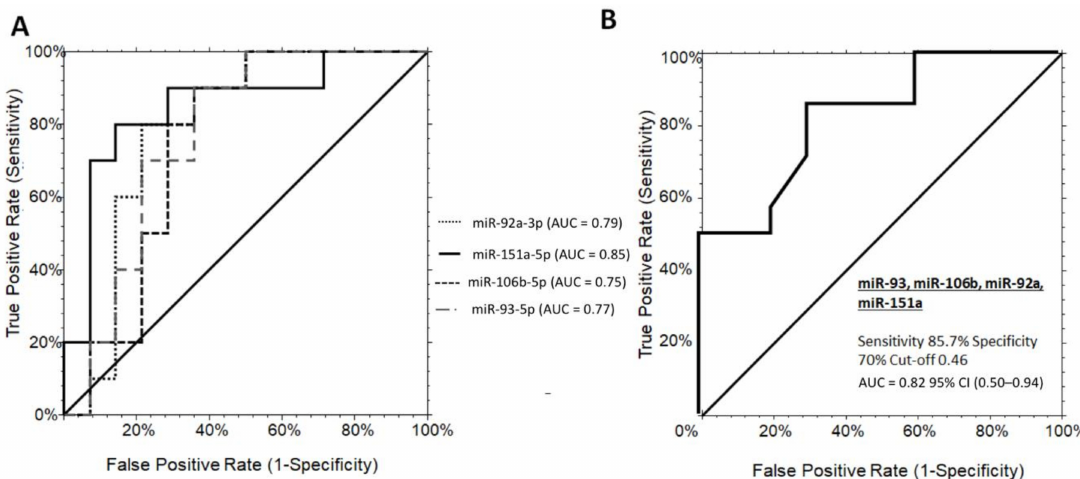
Figure 2. ROC curve analysis of serum miRNAs discriminating grade 1 PWS + from OBS + . ( A ) ROC curves for the single miRNA candidates, miR-151a, miR-92a-3p, miR-106b-5p, and miR-93-5p with optimal sensitivity / specificity value of 80 / 85%, 80 / 78%, 80 / 71%, and 70 / 78%, respectively. ( B ) The AUC for the miRNA panel was 0.82 (95% CI (0.50-0.94), cut-o ff s 0.82, with a sensitivity of 85.7%, and a specificity of 80% (logit model formula: –2.34 + 2.48 * miR-92a-3p + 1.47 × miR-151a-5p + 1.97 × miR-106b-5p - 2.55 × miR-93-5p. OBS + , obese subjects with steatosis; PWS + , Prader–Willi Syndrome with steatosis AUC, area under the ROC curve; CI, confidence